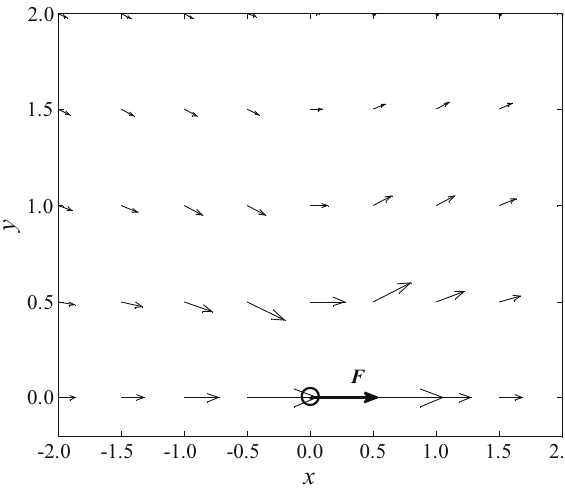
Figure 11: The velocity vector fi eld of an asymmetrical local fl ow induced by a point force F acting close to the